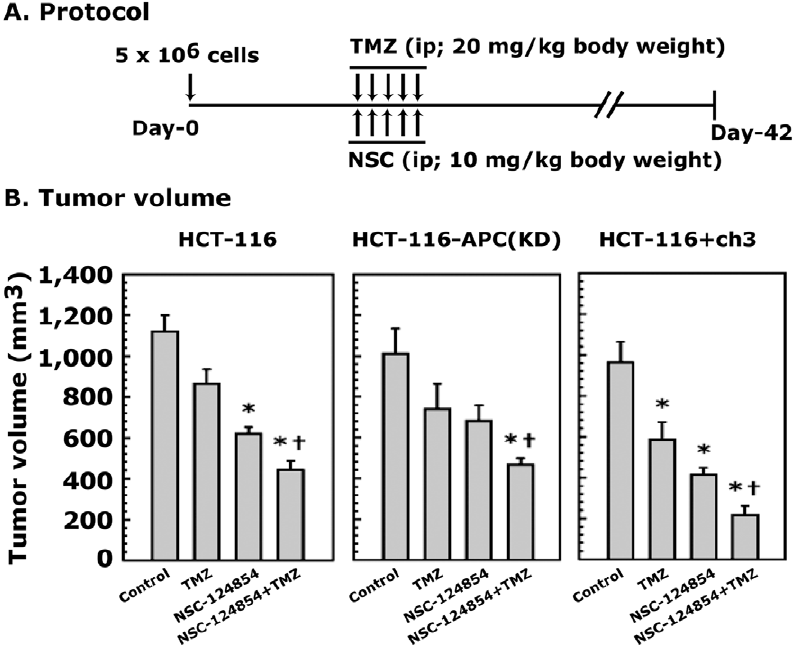
Figure 6. NSC-124854 in combination with TMZ decreases the growth of tumors in a xenograft model. Panel A shows the schematic representation of the experimental protocol. Panel B shows the change in tumor volume at the 42 nd day of the experiment. Data presented are the mean 6 SD of four to six animals in each group. *, significantly different than control; { , significantly different than NSC-124854. P , 0.05. doi:10.1371/journal.pone.0016691.g006 PLoS ONE |